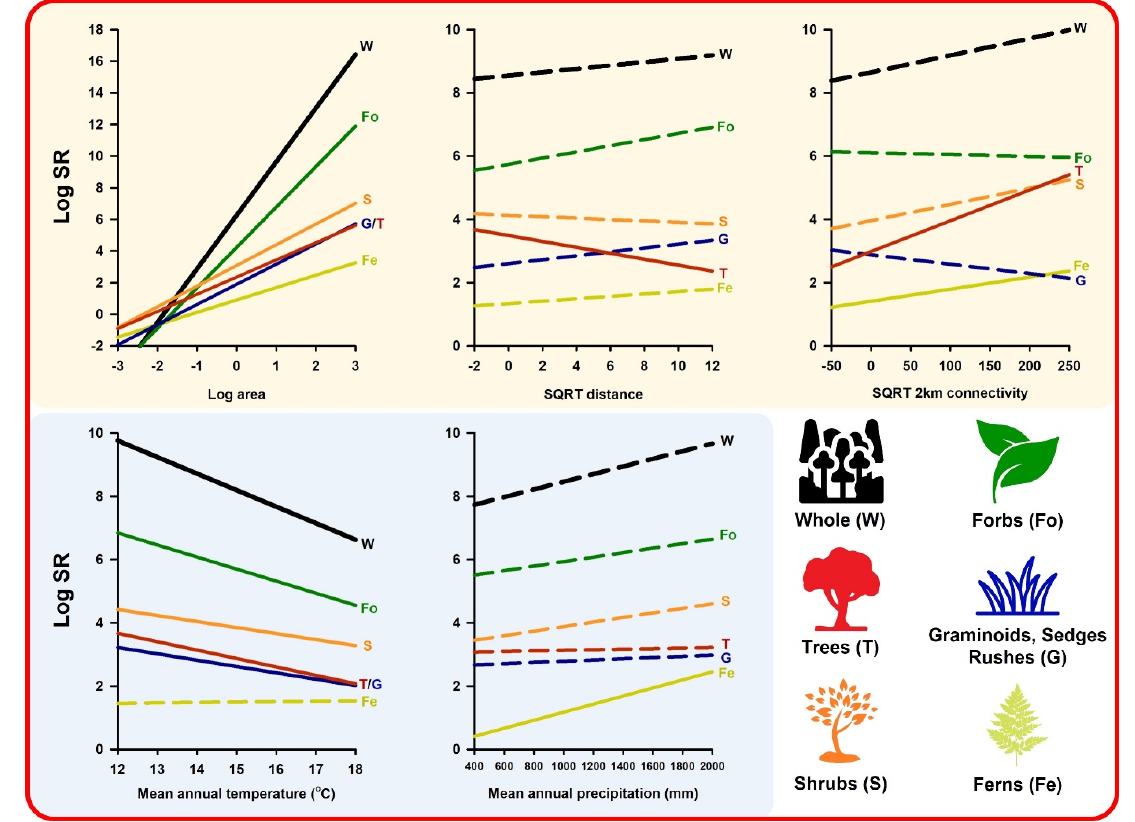
Figure 3. Bivariate relationships between plant growth forms and environmental factors in the overall islands combining inhabited and uninhabited islands, South Korea. Solid and dashed lines represent significant and non-significant effects, respectively. The slopes of lines indicate the strength of correlation. Abbreviations: SR—species richness, area—island area, distance—distance from the mainland, 2 km connectivity—structural connectivity 2000 m, MAT—mean annual temperature, MAP—mean annual precipitation, log—log transformation, SQRT—square root transformation.